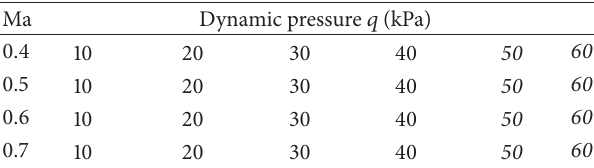
Table 1: Flight conditions of LTI models.